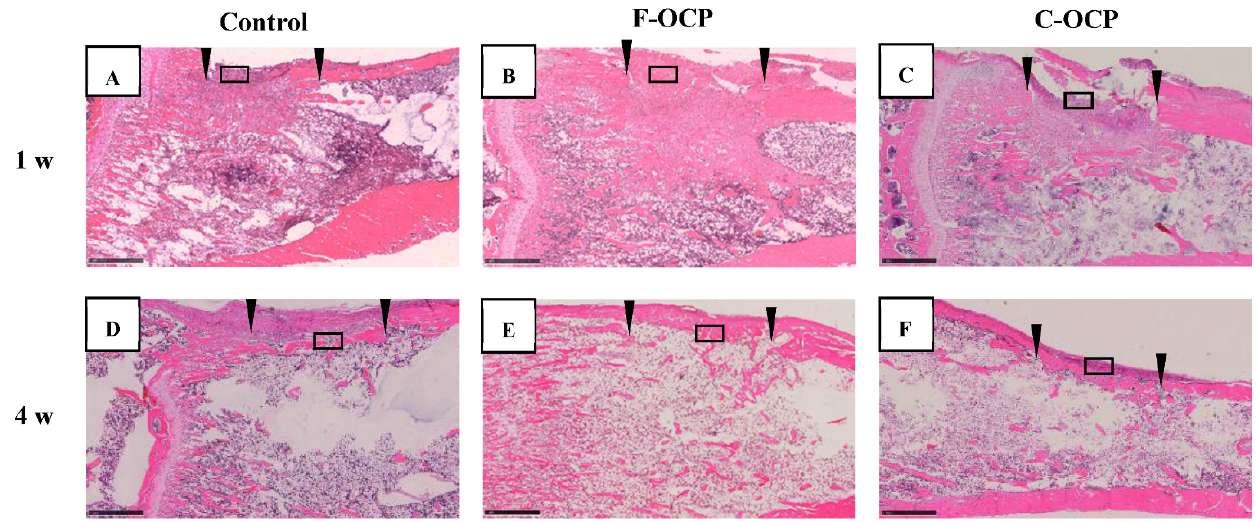
Figure 7. Overview around tibia defect regions of histological sections stained with hematoxylin and eosin after treatment with no materials (control) ( A , D ), F-OCP ( B , E ) and C-OCP ( C , F ) at 1 week ( A – C ) and 4 weeks ( D – F ) post-implantation. Scale bars in the panels represent 1 mm. The open squares indicate the areas shown as higher magnified images in Figure 8. Arrowheads indicate the edge of the defects.